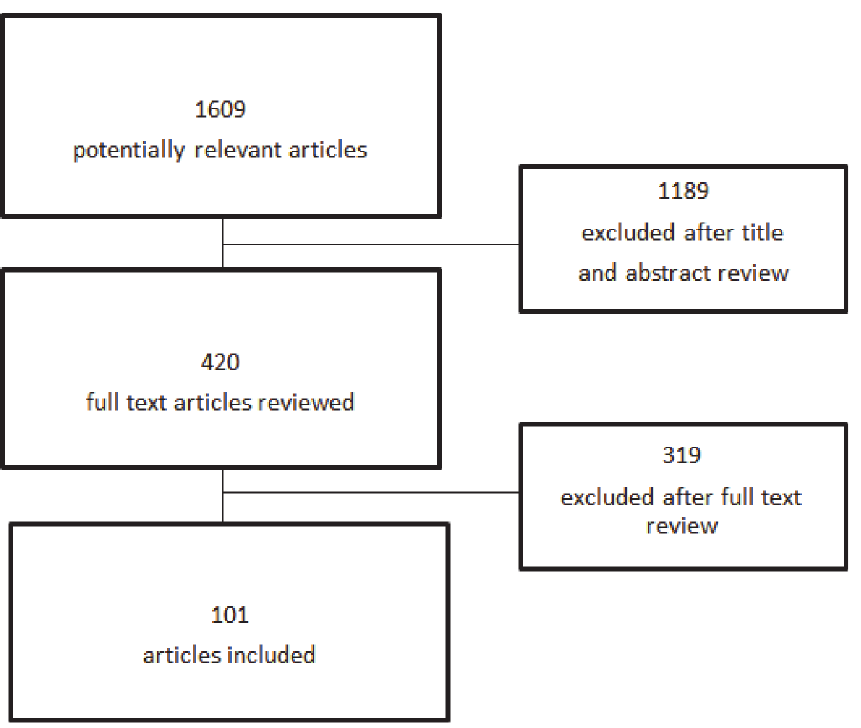
Fig 1. Flow chart of inclusion